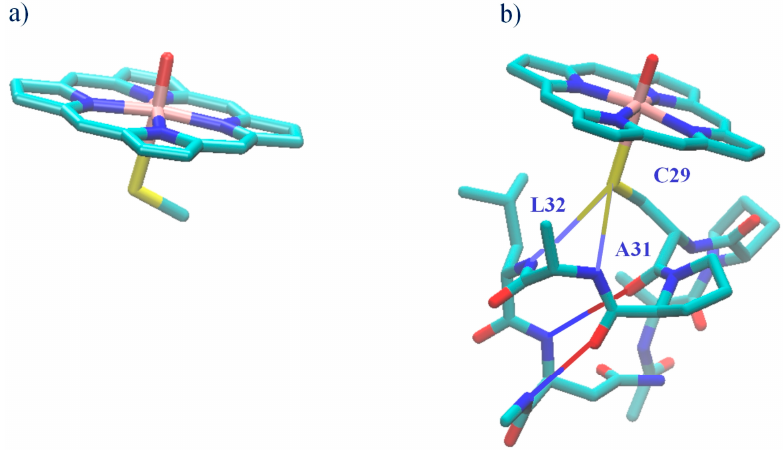
Figure 2. Bare-thiolate, CPO-I-A ( a ); and CPO-like, CPO-I-B ( b ) proximal pocket models of CPO-I.